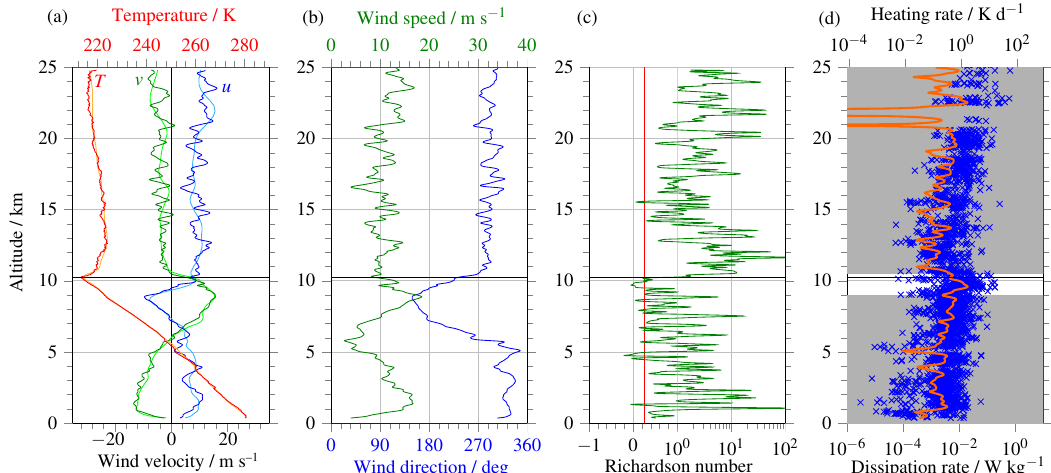
Figure 1. Observations during the BEXUS 12 flight. (a) Zonal winds u (blue), meridional winds v (green), and temperatures T (red) from the radiosonde. The light blue, light green, and orange curves show the corresponding results from the WRF model interpolated along the balloon trajectory. (b) Wind direction (blue) and horizontal wind speed (green) from the radiosonde. (c) Richardson number Ri computed from the radiosonde data, using a smoothing over 150m prior to numerical differentiation. The Ri axis is split at 1 into a linear and a logarithmic part. The red line shows the critical Richardson number, 1 / 4. (d) Energy dissipation rates ε observed by LITOS. The blue crosses mark single turbulent spectra computed on a 5m grid with 50% overlap, the orange curve shows a Hann-weighted running average over 500m (non-turbulent bins count as zero in the average). The top axis gives the heating rate due to turbulent dissipation, d T/ d t = ε/c p . The grey areas mark the regions with likely wake influence. The horizontal black line in all four panels marks the tropopause.